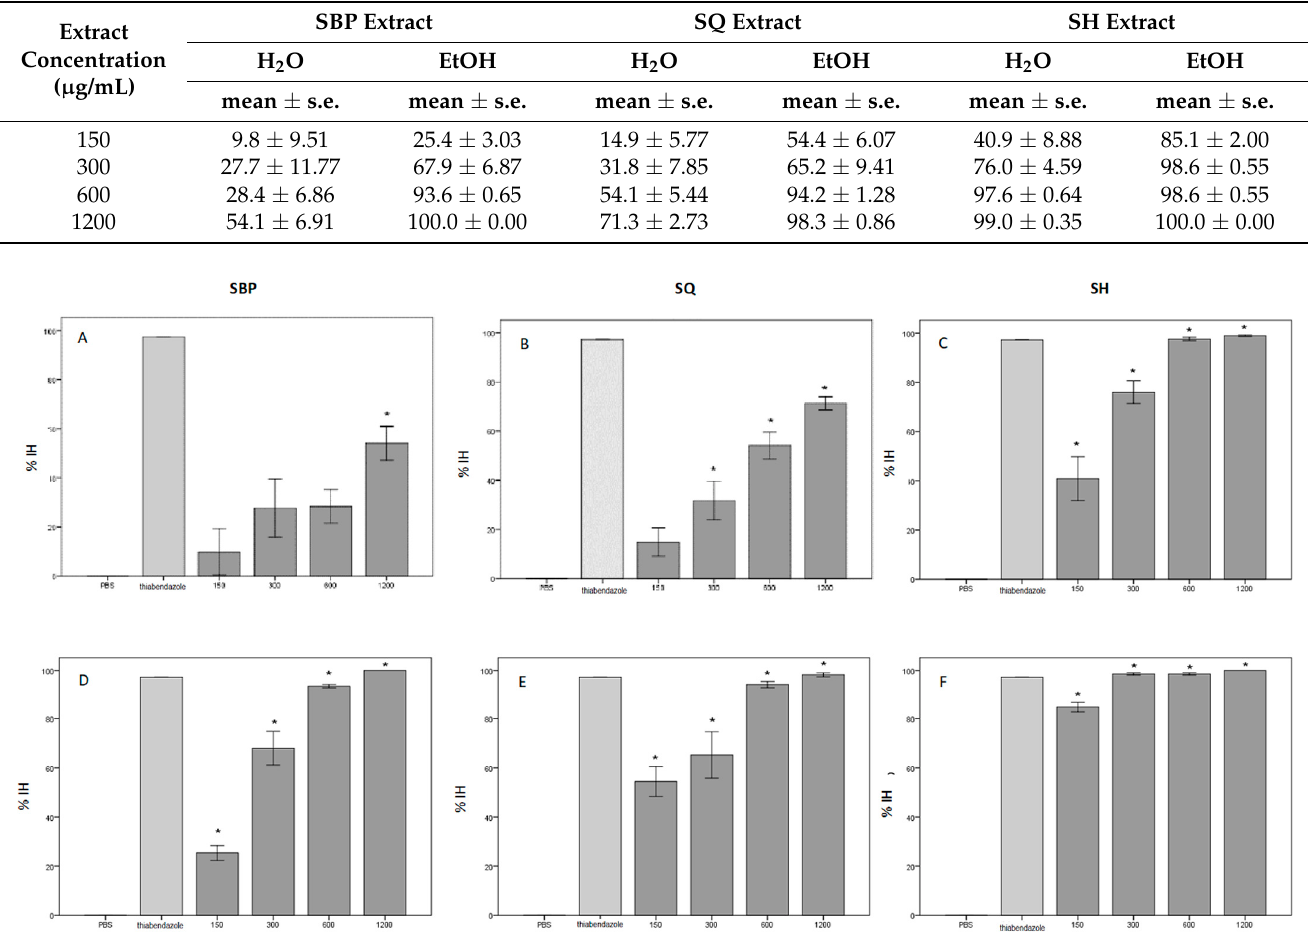
Figure 3. Percentage of inhibition of egg hatching with various concentrations of the tested extracts (%IH). Compared to phosphate buffer saline (PBS) and thiabendazole, %IH of PBS (negative control): 0%, %IH of thiabendazole (positive control): 97.3%. The significant inhibitory effects ( p -value < 0.05, one-way analysis of variance, followed by Dunnett’s post hoc test) are indicated with *. Each bar represents mean ± standard error of the mean. ( A – C ) = H 2 0 (water) extracts; ( D – F ) = EtOH (ethanol) extracts.